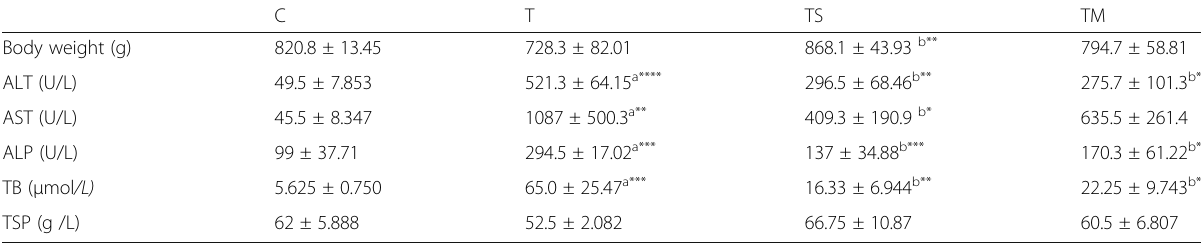
Table 3 Effect of SCG and MCG extracts on the body weight and serum biochemical markers on CCl 4 induced hepatoxicity in rabbits